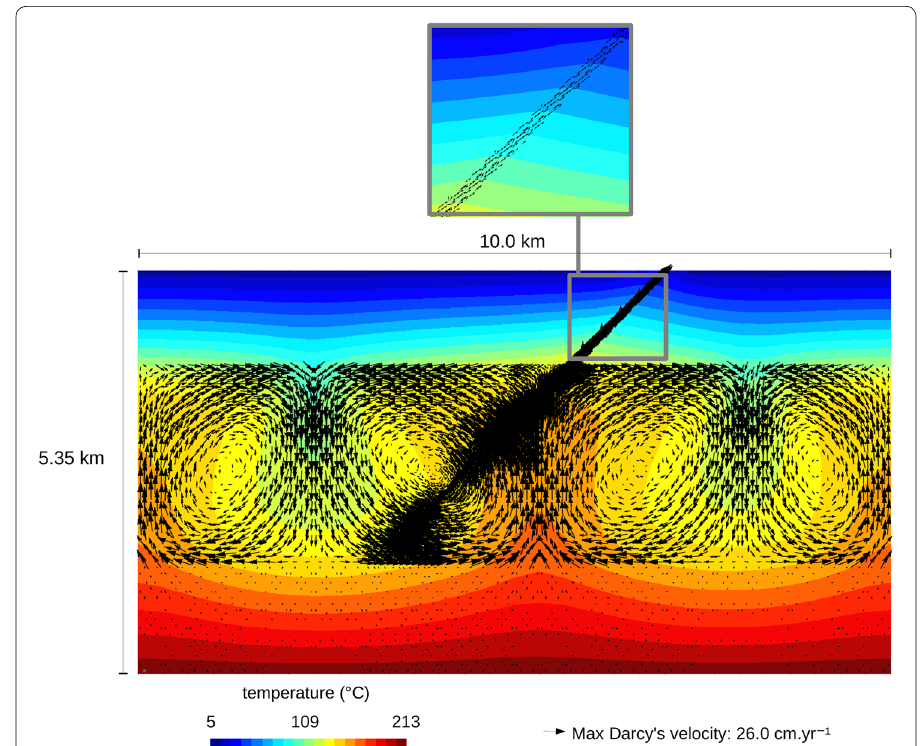
Fig. 9 Maps of calculated temperatures (background colors) and Darcy’s velocities (black arrows) in the model including the Rittershoffen fault with dip of 45